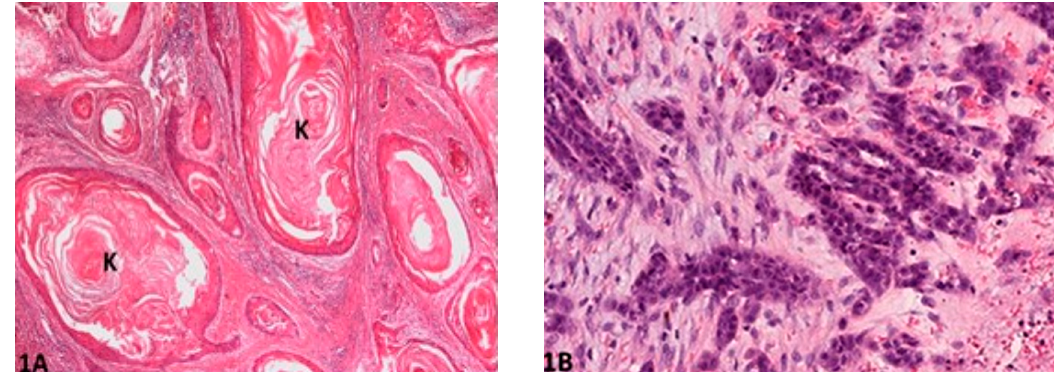
Figure 1. Degree of keratinization: ( A ) (O.M. 2 × ): Well-differentiated and highly keratinized cells (K) with over 50% of keratinization (Gordon Setter, No. 49); ( B ) (O.M. 10 × ): Less than 5% cells exhibiting keratinization (Gordon Setter, No. 55). O.M: original magnification.